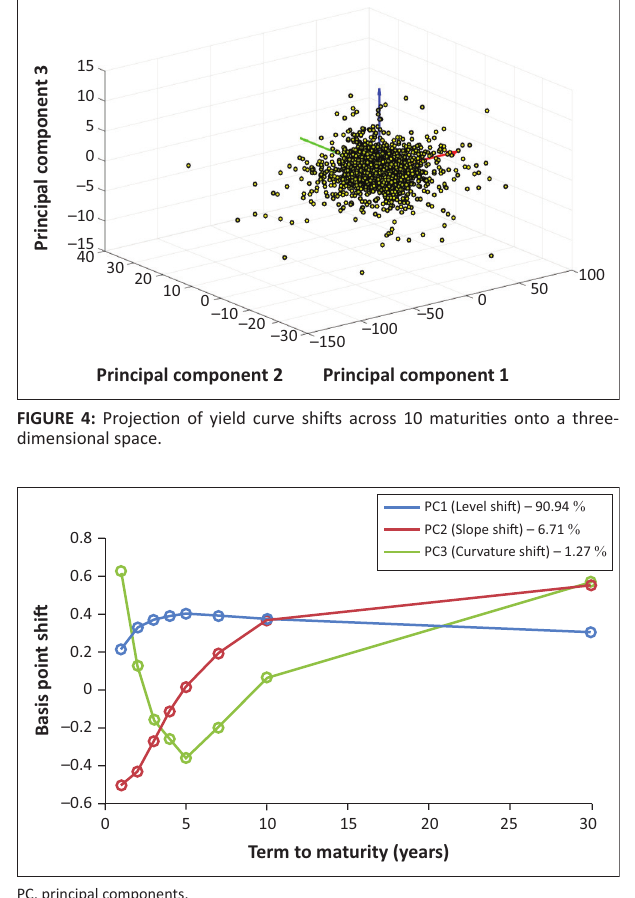
FIGURE 5: Three principal components of yield curve shifts for entire